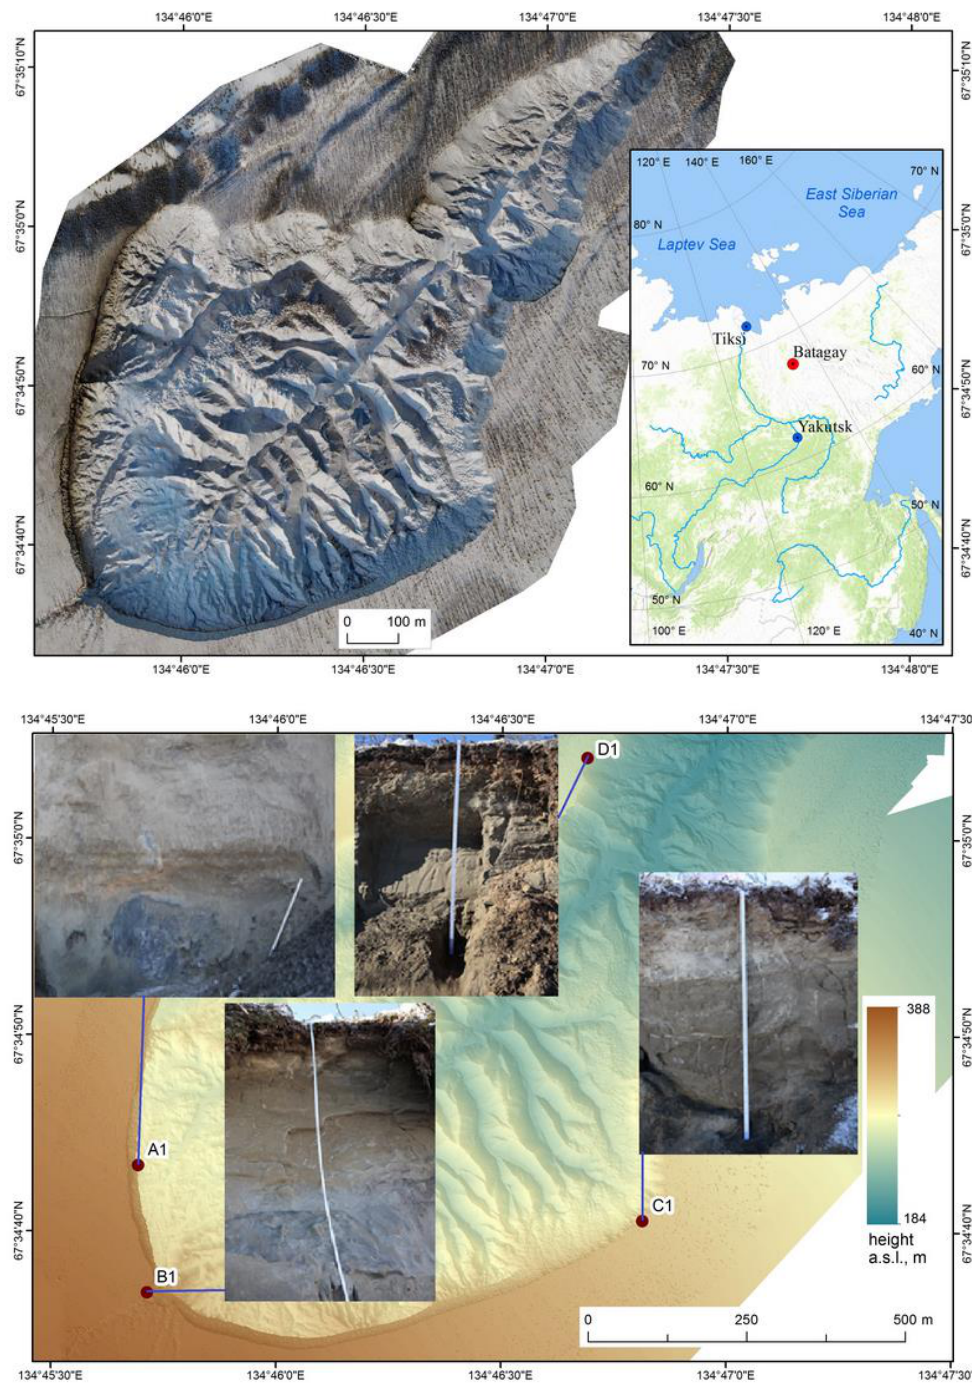
Figure 1. Batagay megaslump location in the Yana Upland in Northeast Yakutia and orthophotomosaic overview based on unmanned aerial vehicle (UAV) data from April 2019. Digital Surface Model (DSM) based on UAV data from April 2019. Sampling locations: The lower Ice Complex (A1), the upper Ice Complex (B1, C1) and cover deposits in the ravine (D1).